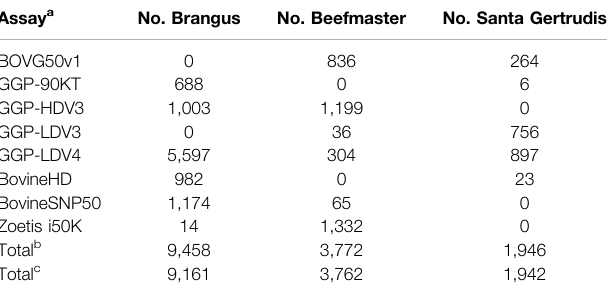
TABLE 1 | Genotyped samples for the American Breeds. Assay a